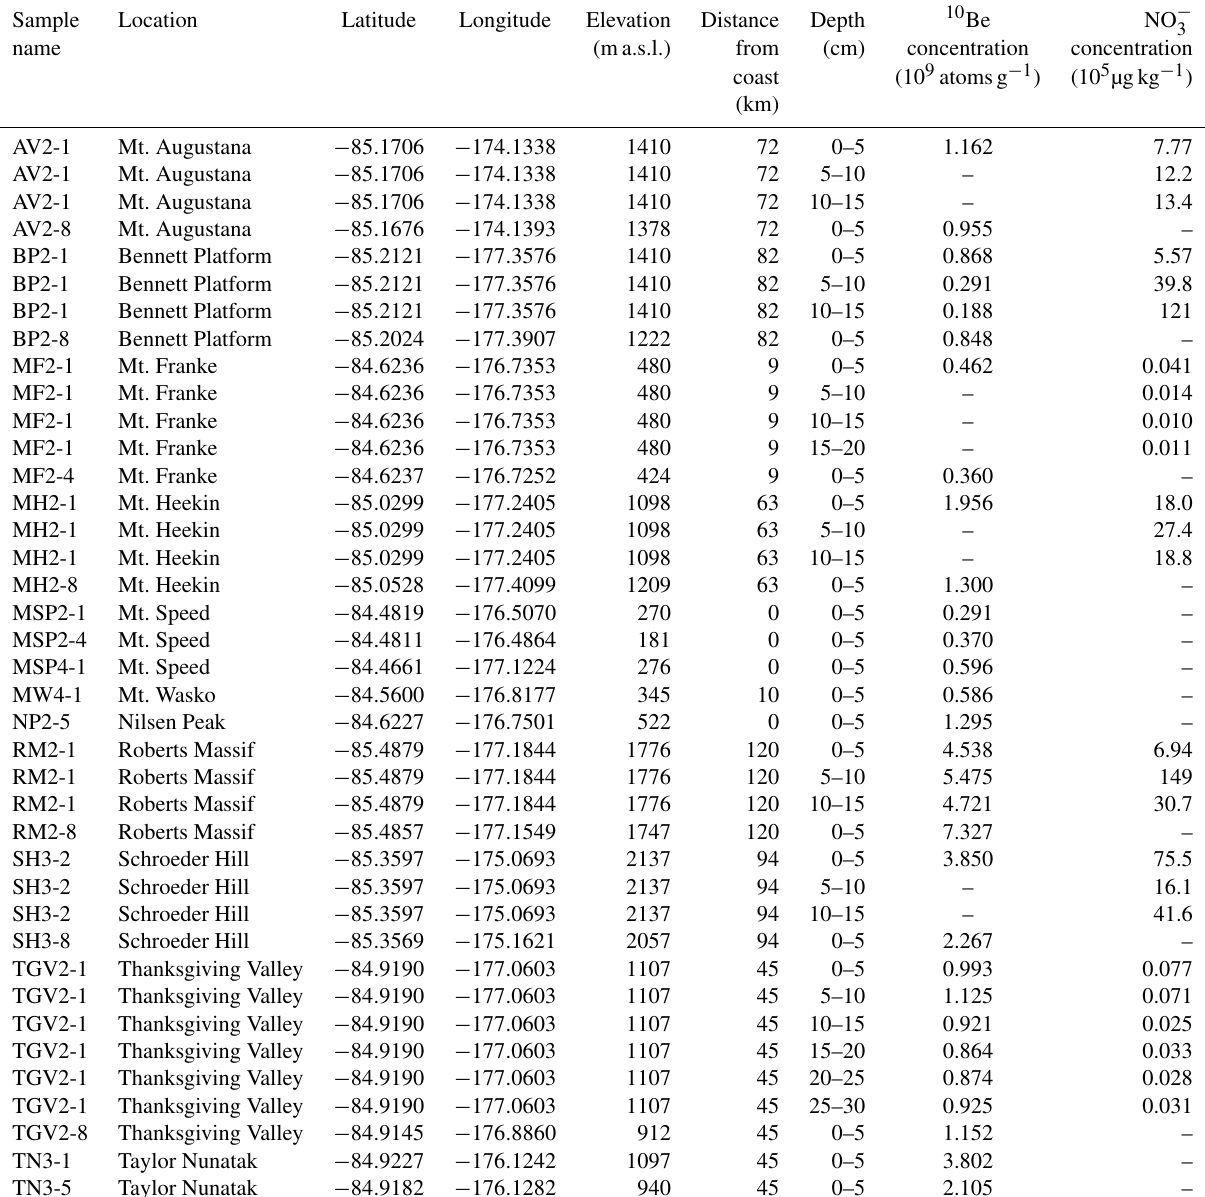
Table 1. Concentrations of meteoric 10 Be and water-soluble nitrate (NO Additional information on 10 Be corrections is located in Table S2.